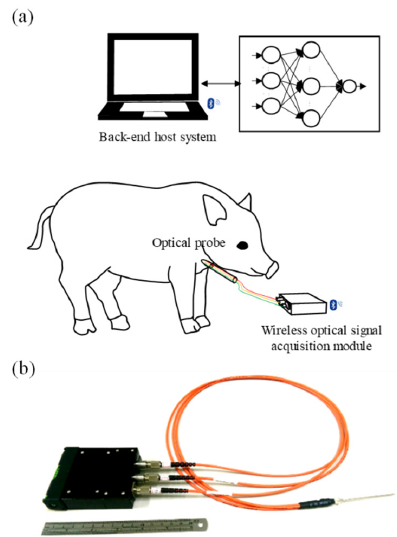
Figure 1. ( a ) Basic schematic and ( b ) photograph of proposed assistance system for blood vessel catheter placement .